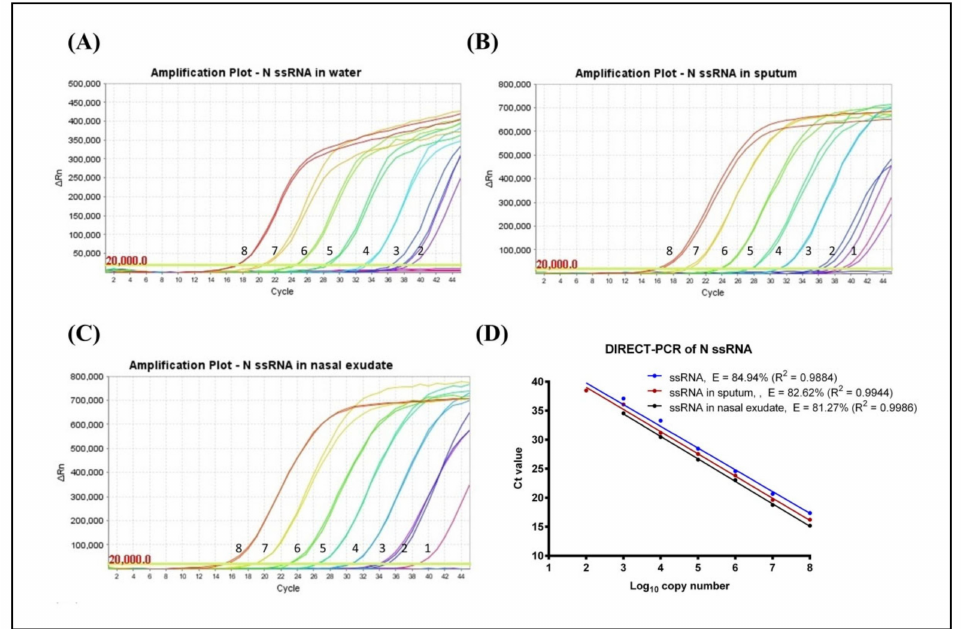
Figure 1. Amplification plot of SARS-CoV-2 N gene ssRNA control in ( A ) water, ( B ) spiked in sputum, and ( C ) spiked in nasal exudate conducted in the same thermocycler run. Numbers indicated the log 10 copy number of the template present. No amplification was observed in the NTC. ( D ) Comparison of DIRECT-PCR assay amplification of SARS-CoV-2 N gene ssRNA control (blue line), N gene spiked in sputum (red line) and N gene spiked in nasal exudate (black line). Templates were ten-fold diluted in 8 orders of magnitude. Two microliters of template was used in 20 µ L of PCR mastermix on the benchtop thermocycler. The amplification e ffi ciency (E) was determined by plotting of mean C q values against log 10 copy number calculated using theoretical molarity of